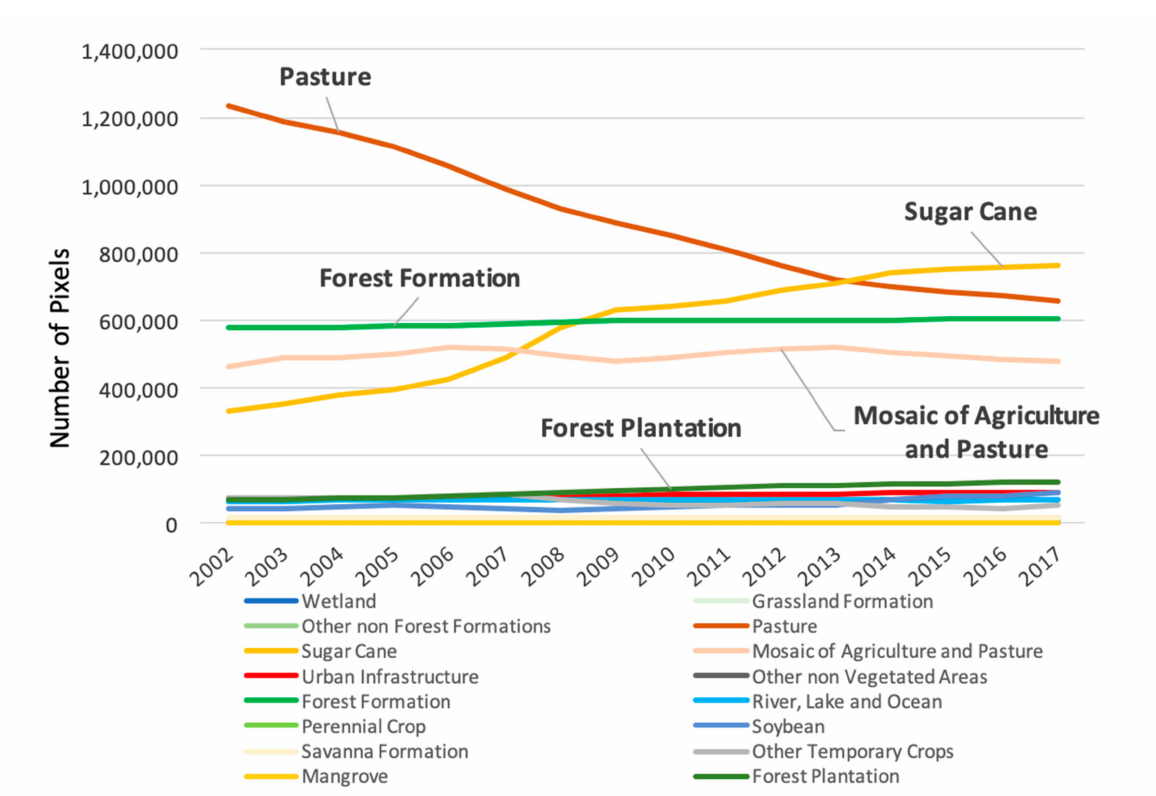
Figure 5. Line chart of pixel counts for each land use type and each year. Shows that natural forest formation and mosaic of agriculture and pasture have been largely unchanged over the study period. Demonstrates the inverse relationship between pasture and